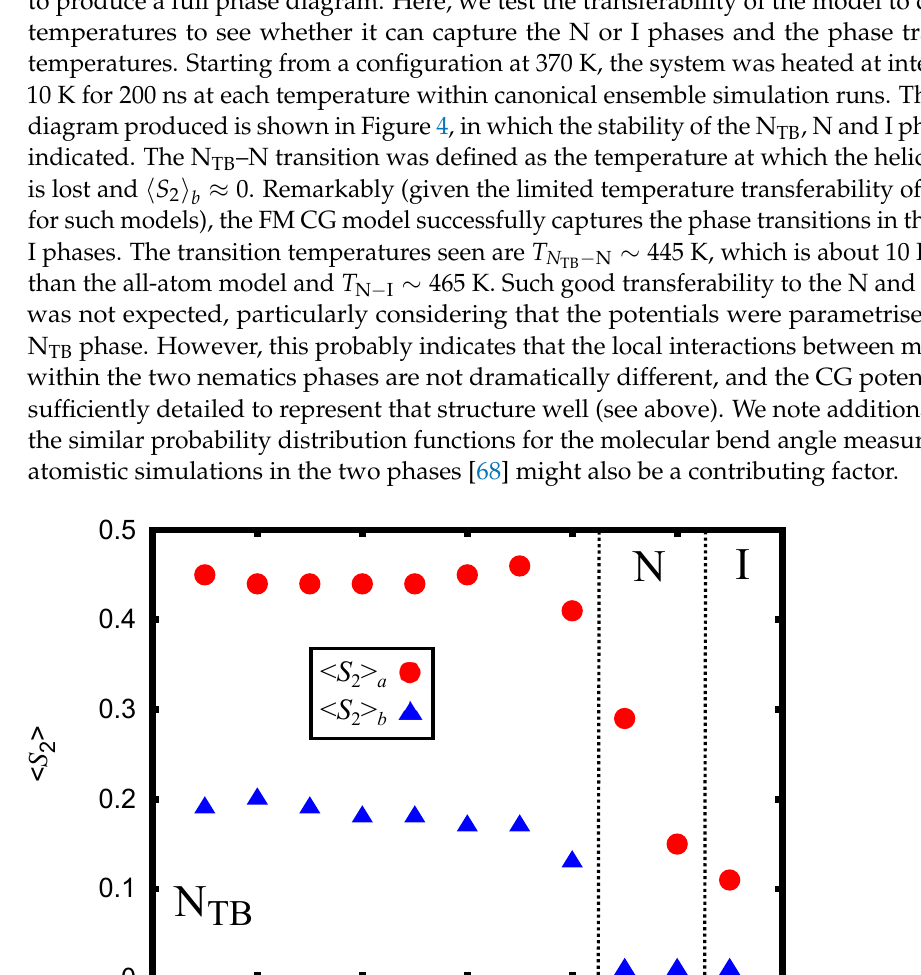
Table 5. The order parameters ( (cid:104) S 2 (cid:105) and 3 CG models of CB7CB at 370 K.